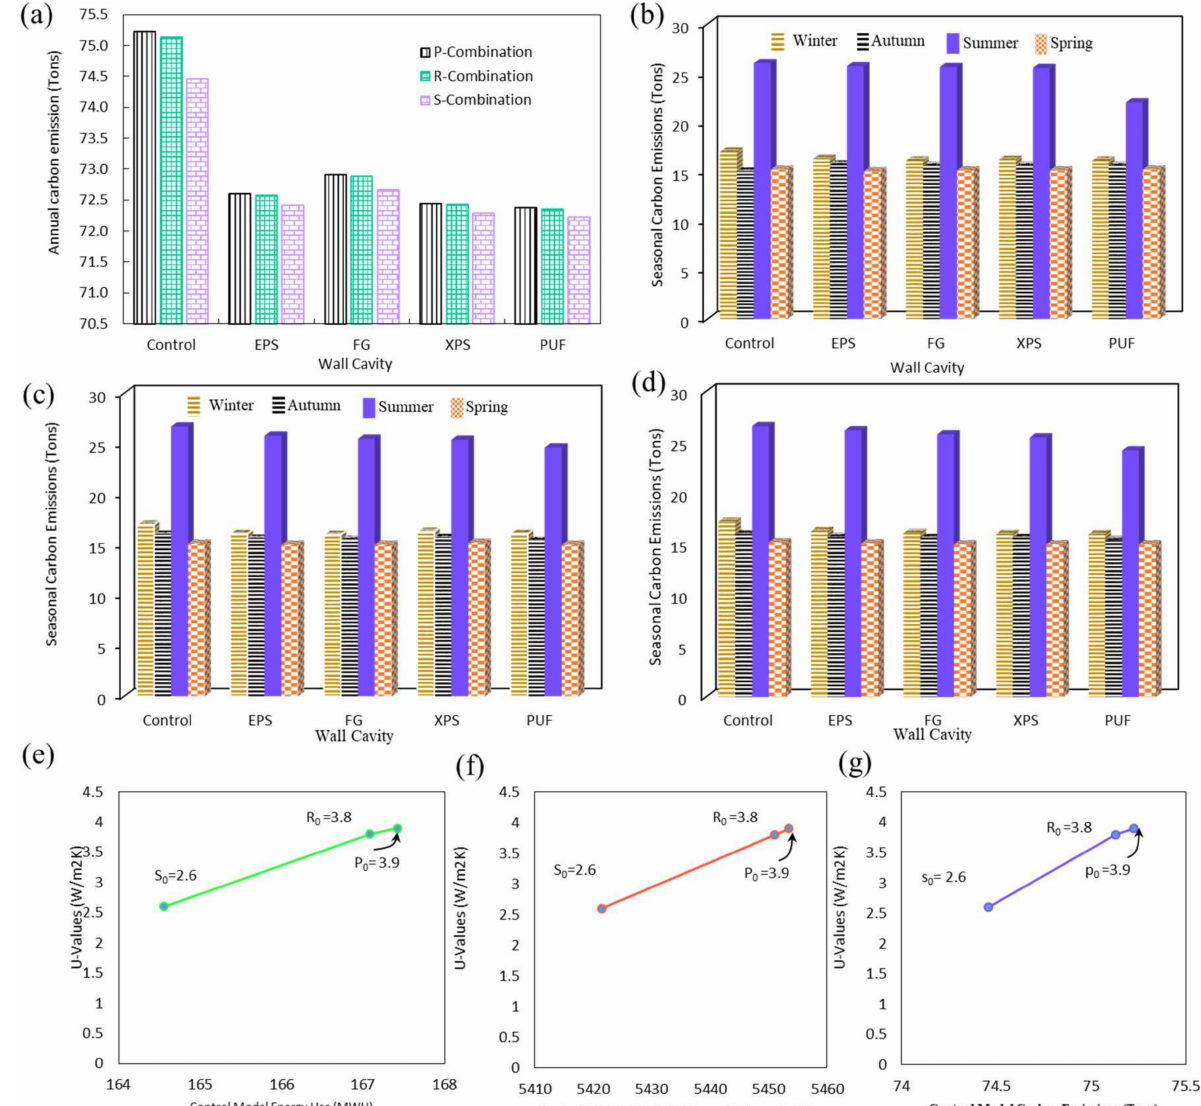
Figure 6. ( a ) Insulation effects on operational carbon emissions of infilled wall cavities. Variations in seasonal carbon production of insulated 3DPC walls for ( b ) Mix 1, ( c ) Mix 2, ( d ) Mix 3. ( e ) Correlation between U-value and energy use. ( f ) Correlation between U-value and thermal comfort performance. ( g ) Correlation between U-value and carbon